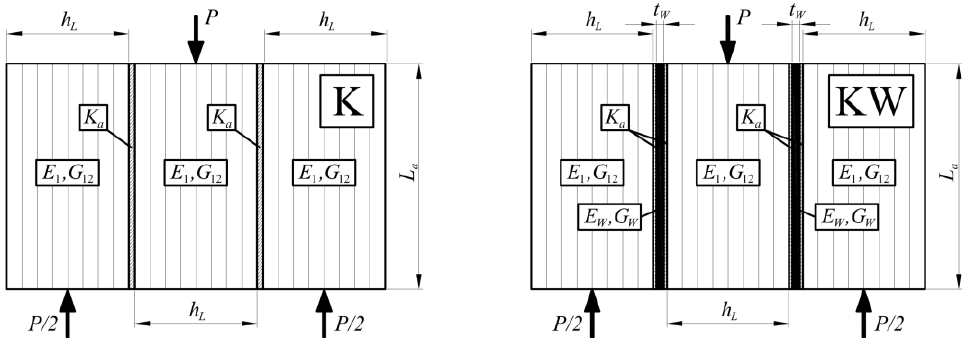
Figure 14. Denotations for the modified Tsai double-lab model (compare with Figures 10 and 11).